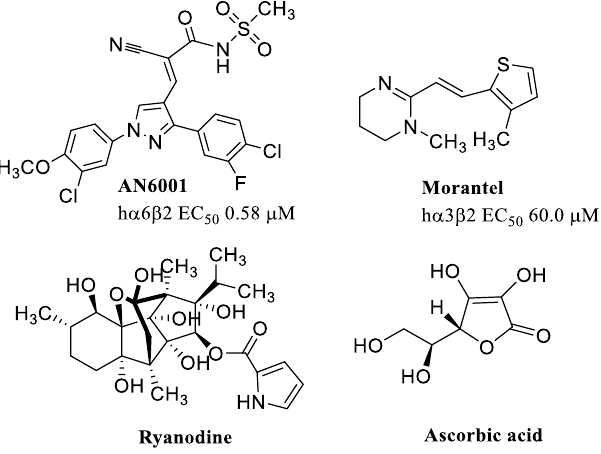
Figure 15. Allosteric modulator of α 6 β 2*, α 3 β 2, and α 9 α 10 nAChR subtypes. Morantel (Figure 15) is a widely used anthelmintic, not for human use, in worm infec- tions, but already described as a PAM of h α 3 β 2 nAChRs (EC 50 = 60 µ M) [114]. Morantel increases the current when applied together with ACh by binding to non-canonical sites in the β (+)/ α ( − ) subunit interface [115,116].